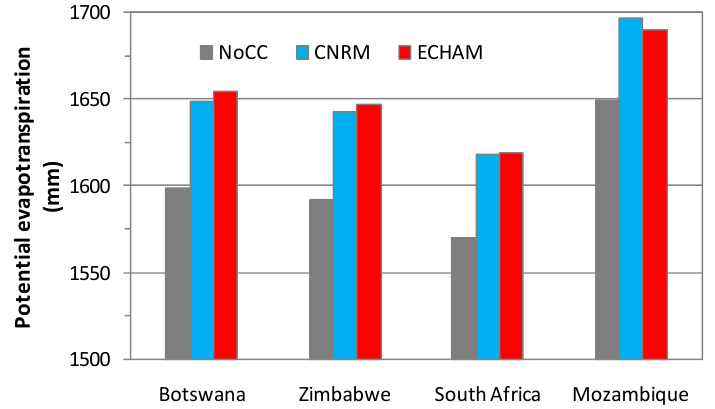
Figure 8. Annual mean potential evapotranspiration under the 1971–2000 climate baseline and climate change scenarios for